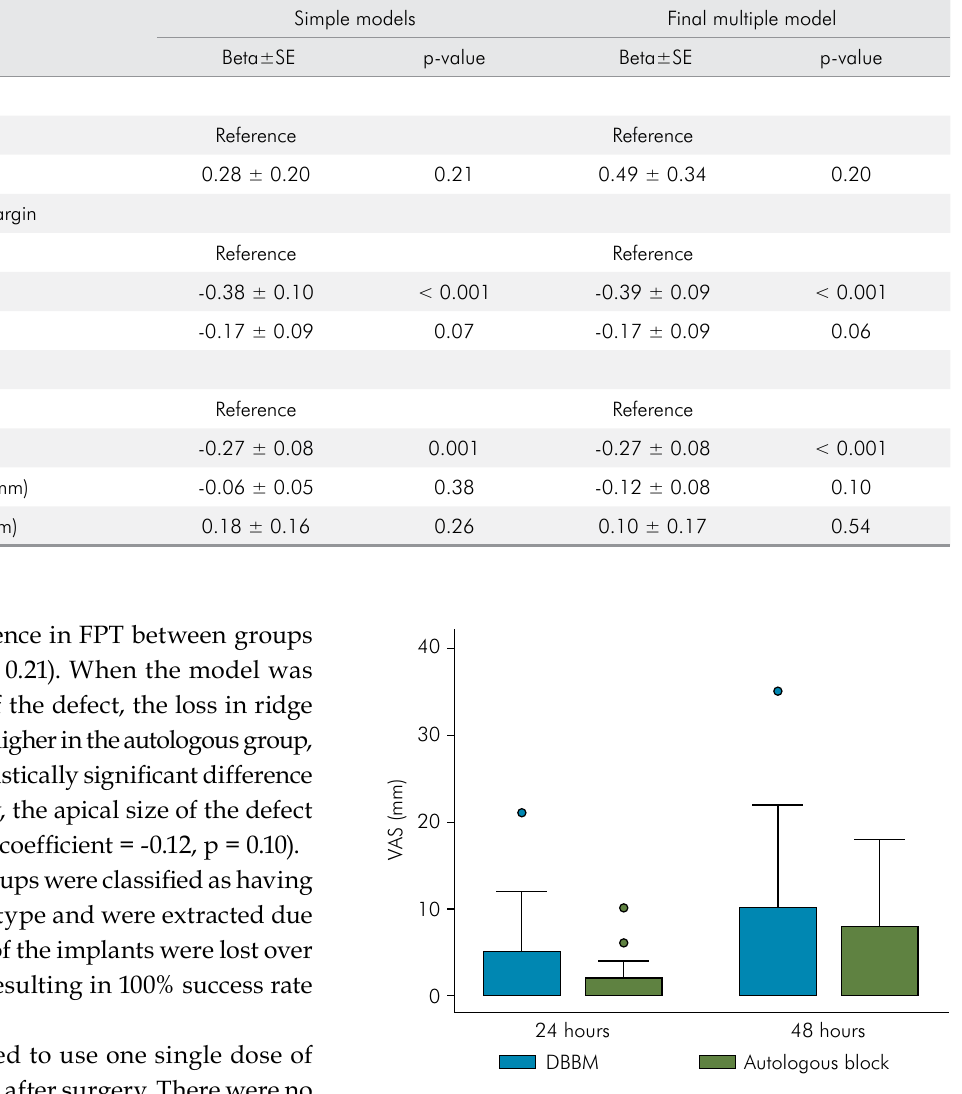
Table 3. Simple and final multiple adjusted generalized estimating equations models for the comparison between DBBM and autologous graft in the difference of facial-palatal ridge thickness (mm) between the implant site and the contralateral